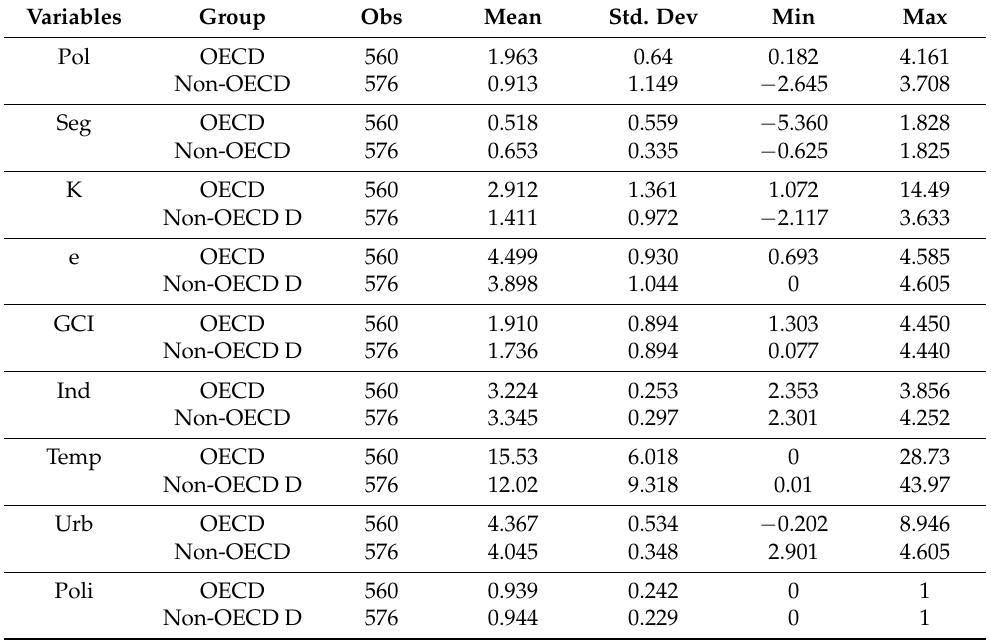
Table 2. Descriptive